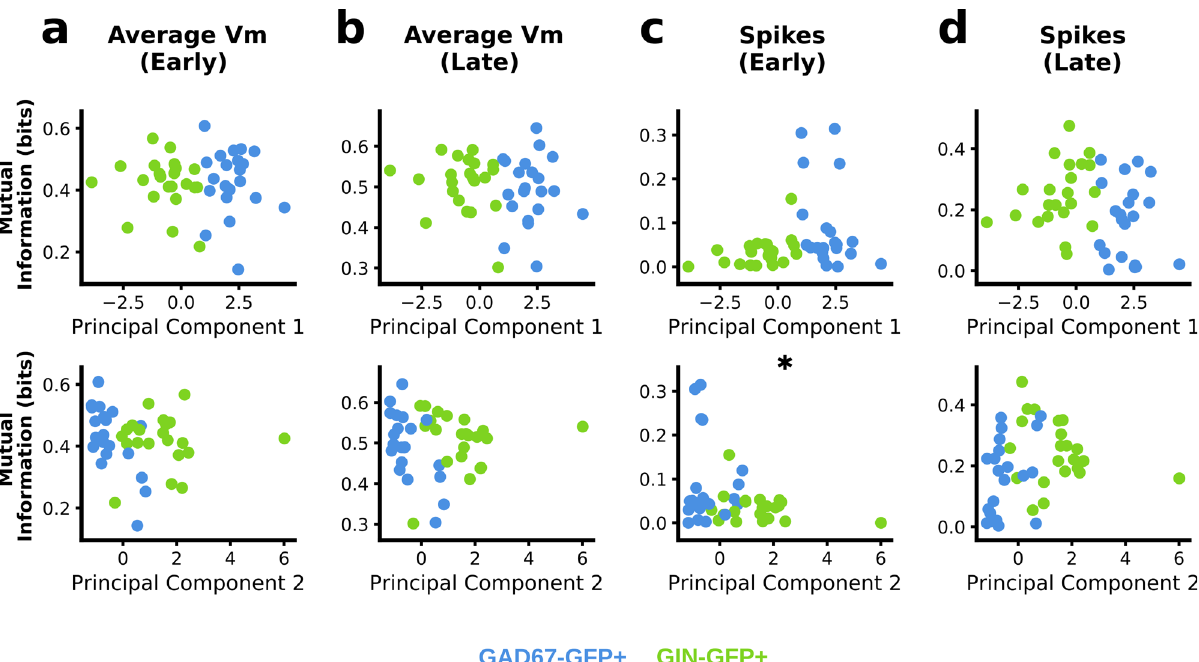
Fig. 6 Mutual information between early spike counts in recorded neurons and synchrony code correlates with second principal component of electrophysiological features in GAD67 + and GIN + interneurons. a Mutual information between average membrane potential and 1-bit synchrony coded signal correlated with fi rst and second principal components (PC1 and PC2, respectively) of electrophysiological features in the early window (PC1: Pearson ’ s r = − 0.04, p = 0.818; PC2: Pearson ’ s r = − 0.17; p = 0.281). b Same as ( a ) but comparing later average membrane potential responses (PC1: Pearson ’ s r = − 0.13; p = 0.394. PC2: Pearson ’ s r = − 0.09, p = 0.583). c Conditional mutual information between spike counts and 1-bit synchrony coded signal correlated with fi rst and second principal components of electrophysiological features in the early window (PC1: Pearson ’ s r = 0.27, p = 0.084; PC2: Pearson ’ s r = − 0.32, p = 0.037). d Same as ( c ) but comparing spike counts in later window (PC1: Pearson ’ s r = − 0.21, p = 0.169; PC2: Pearson ’ s r = 0.20, p =